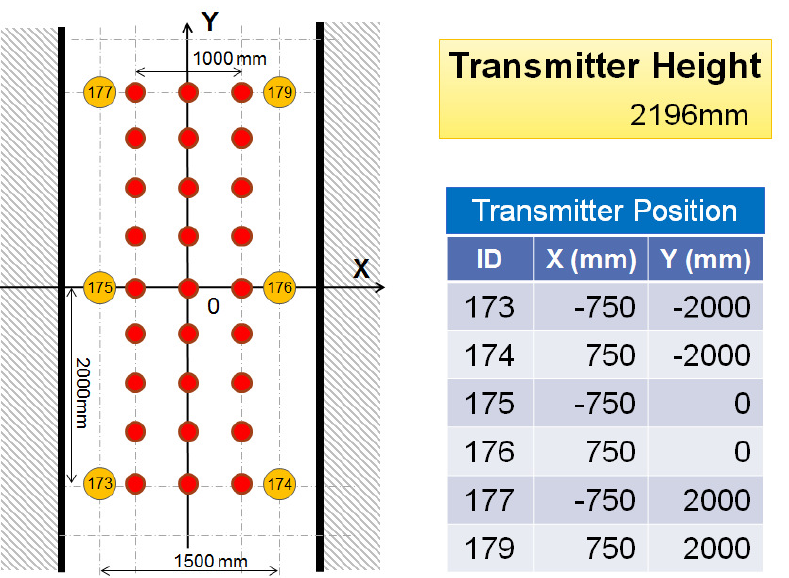
Figure 4. Localization points used for trilateration experiments.